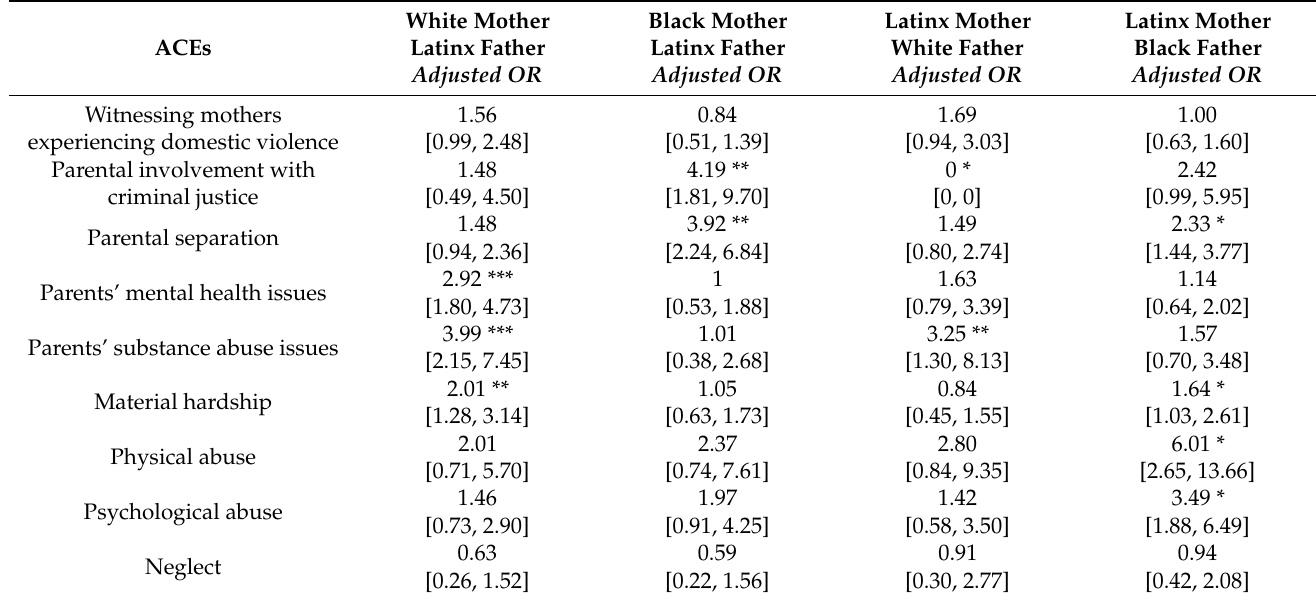
Table 4. Logistic regression models for predicting each